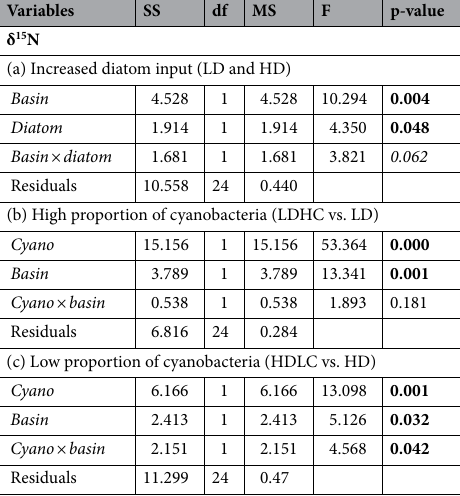
Table 1. Results from two-way ANOVA model, testing the effect of diatoms and cyanobacteria in the diet (a: diatom ; b and c: cyano ) and basin (BoS vs. BP) as main factors and their interactions ( basin × diatom or basin × cyano ) on δ 15 N values in amphipods. See Fig. 3. Significant values are in bold and marginally significant values (< 0.1) in